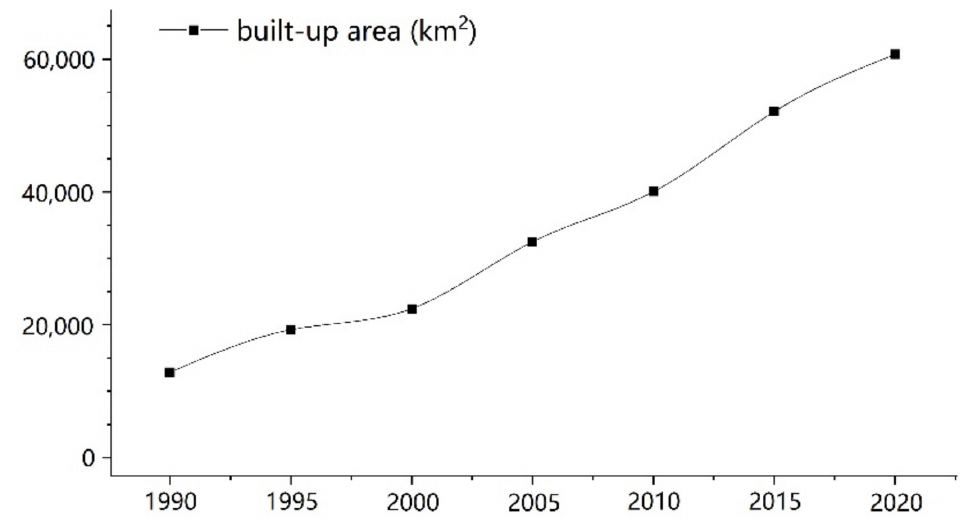
Figure 1. Change in urban built-up area in Chinese mainland from 1990 to